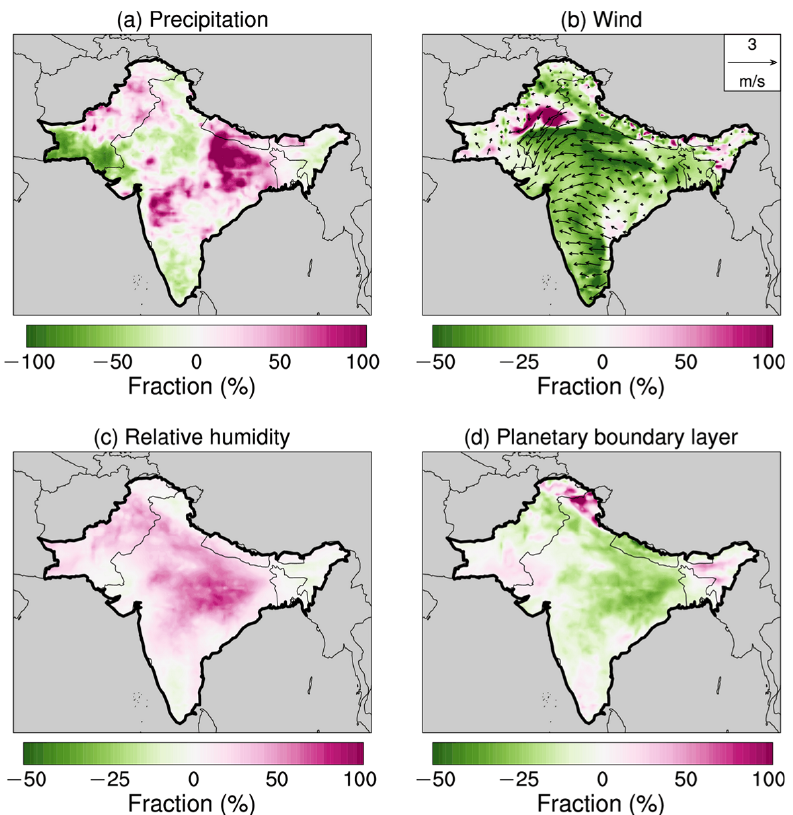
Figure 7. Fractional changes (%) ((lockdown minus climatology)/(climatology average)) in ( a ) precipitation, ( b ) wind speed (m/s), ( c ) relative humidity, and ( d ) planetary boundary layer. Data retrieved from ERA5 reanalysis.